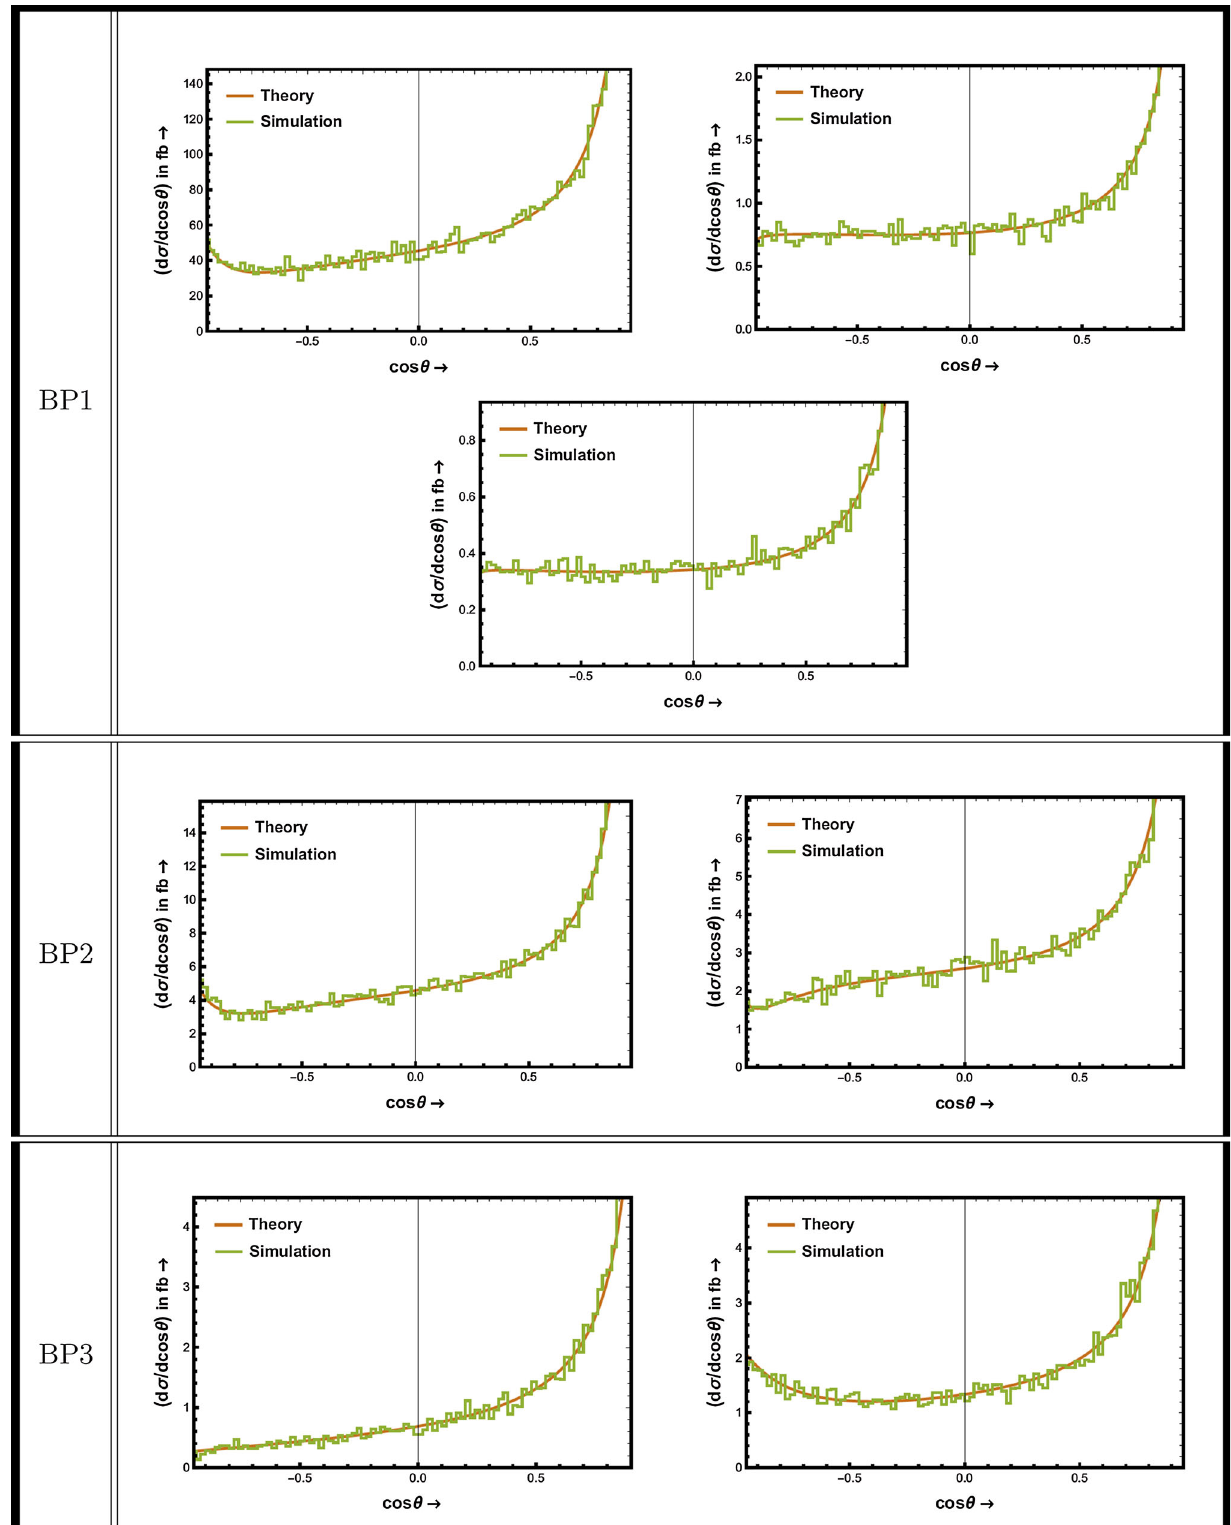
/ 3 ) c at various ical expectations, whereas the green (jagged) lines signify the PYTHIA 2 simulated